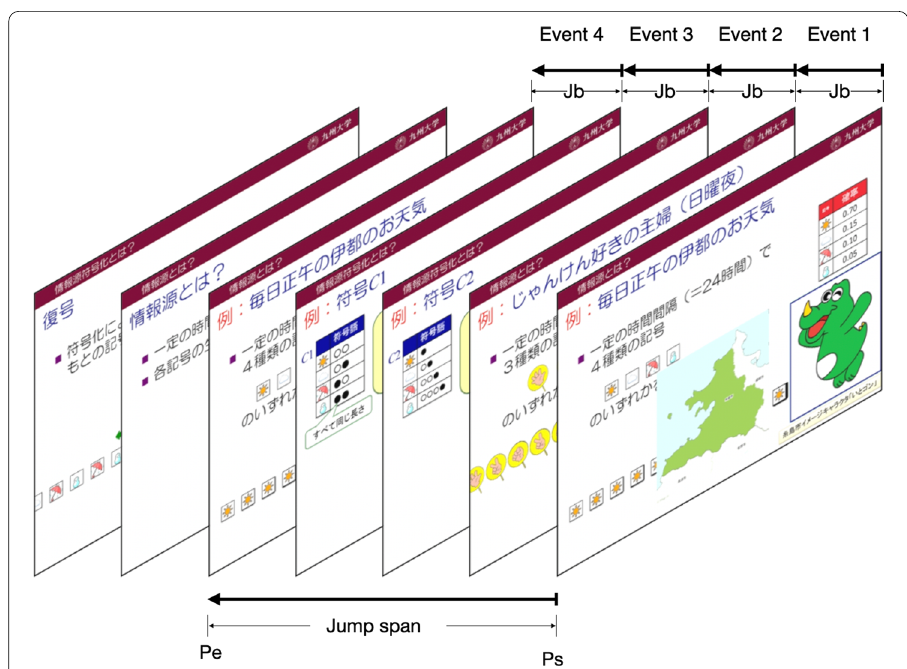
Fig. 4 Complete-jump pattern